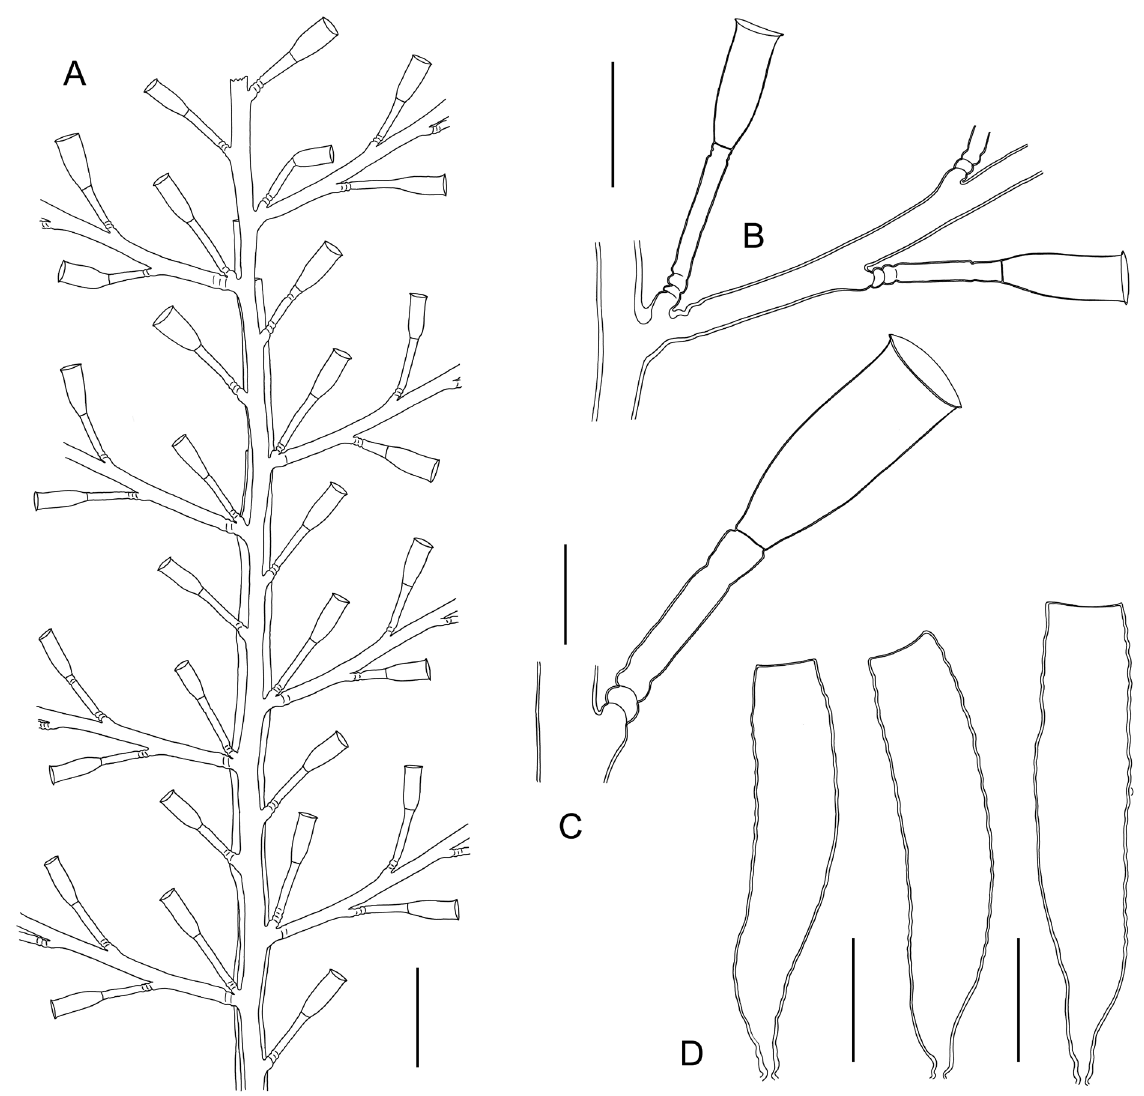
Fig. 19. Zygophylax niger Galea, sp. nov. A–D . Tip of colony showing mode of branching (A), portion of stem with axillar hydrotheca and proximal part of cladium (B), hydrotheca atop its pedicel (C), three gonothecae (D), all from sample MNHN-IK-2015-479. Scale bars: A = 1 mm; B, D = 500 µm; C = 200